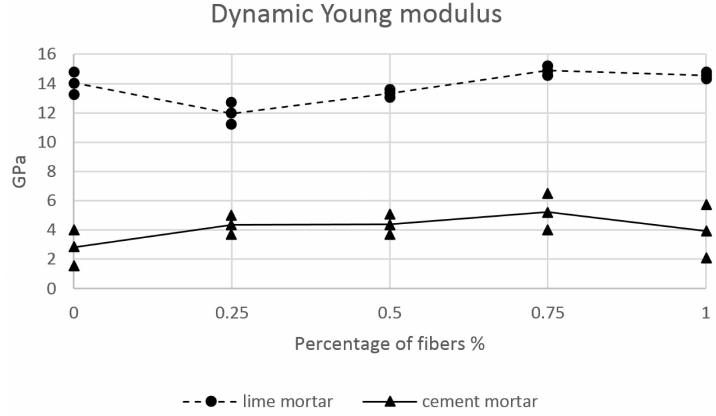
Figure 14. Ultrasonic estimation of Young Modulus of